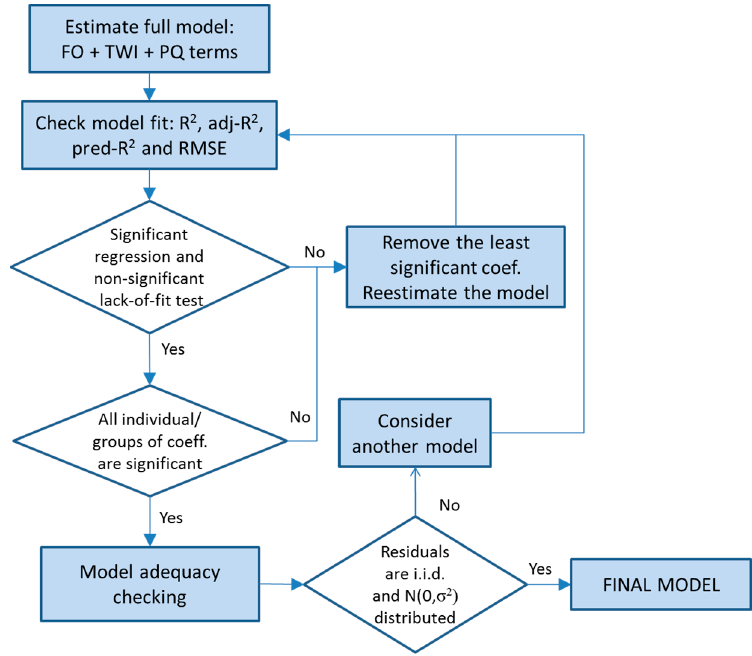
Figure 2. Model selection scheme.